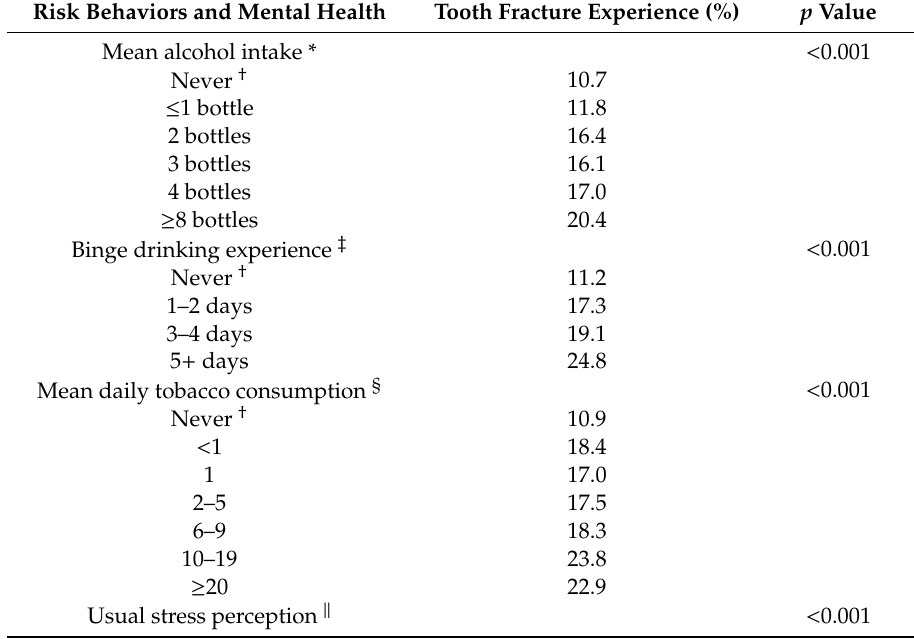
Table 2. Tooth fracture experience related to health-risk behaviors and mental health